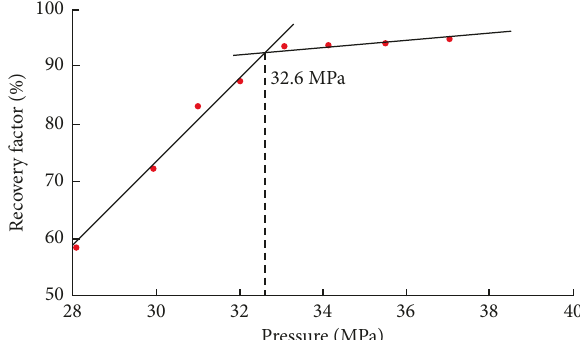
Figure 1: Recovery factor versus pressure to determine the minimum miscibility pressure.